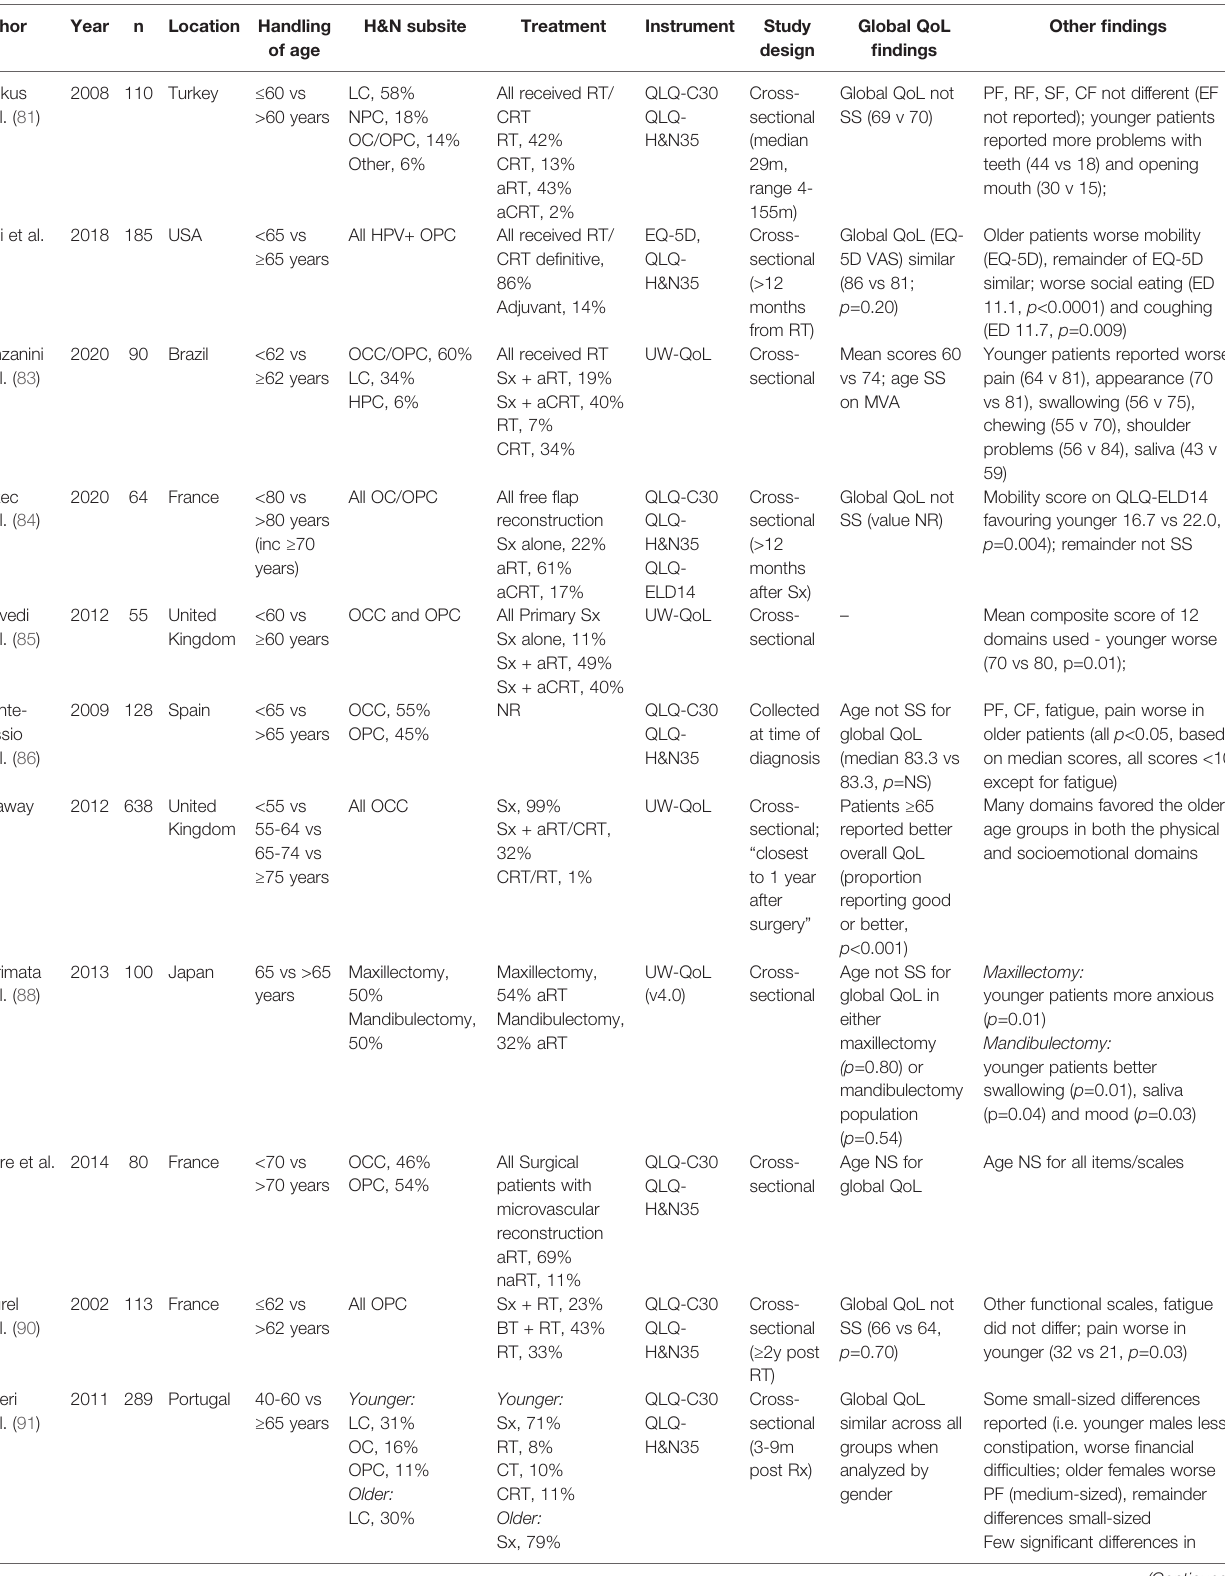
TABLE 3 | Cross-sectional studies reporting health-reported quality of life in elderly HNSCC cohorts.